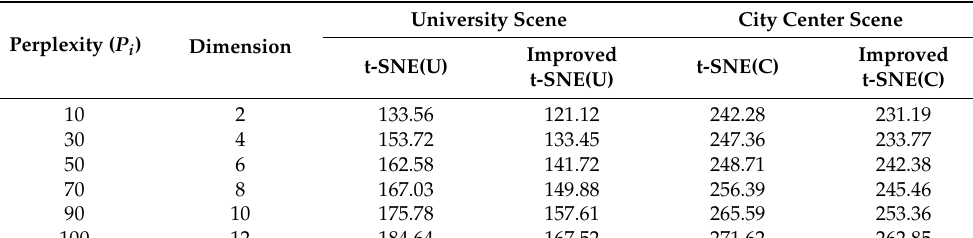
Table 6. Computation time of improved t-SNE and t-SNE for university scene (U) and city center scene (C).